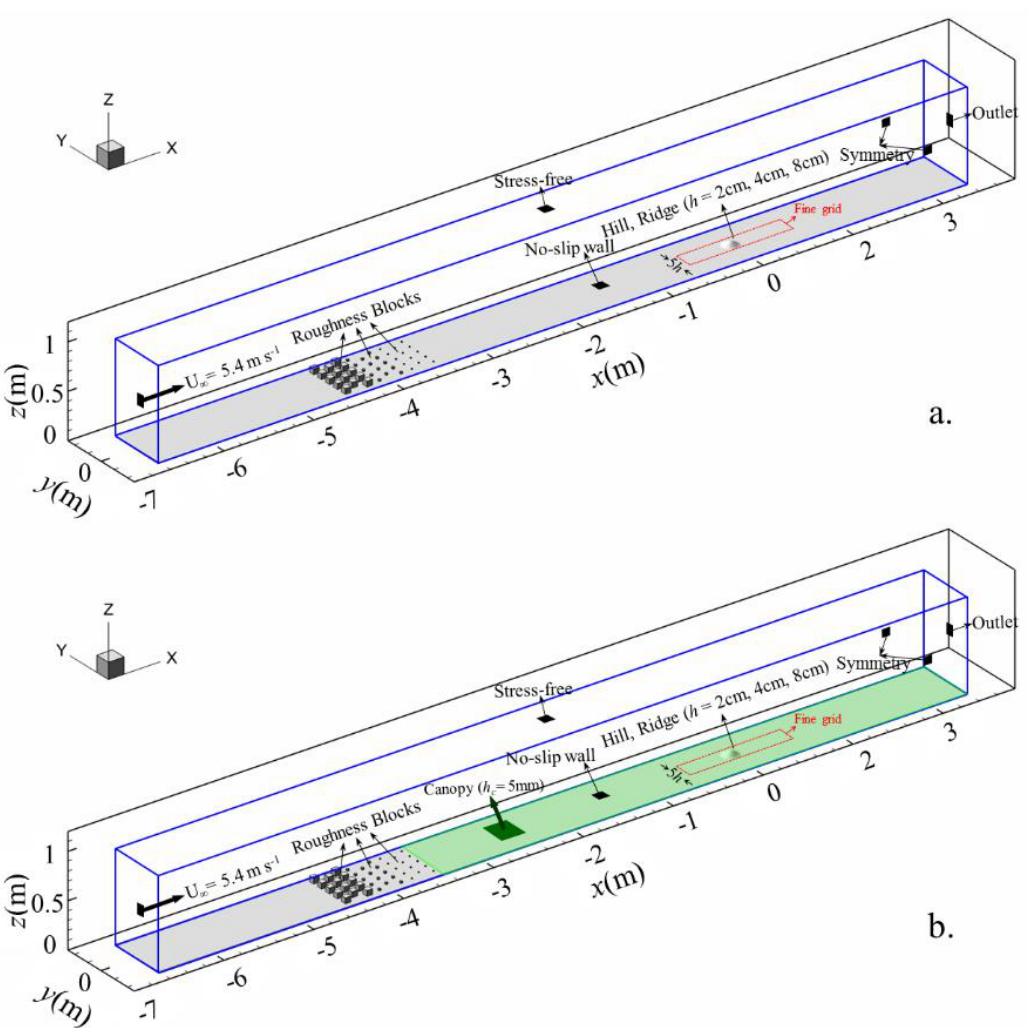
Figure 1. Sketch of the computational domain ( a ) smooth ground and ( b ) rough ground.